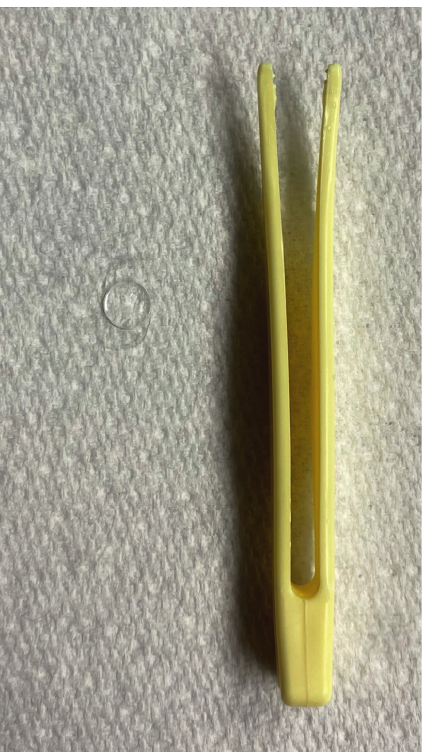
Figure 2: An intraocular lens, set on absorbent paper to remove surplus fluid prior to being